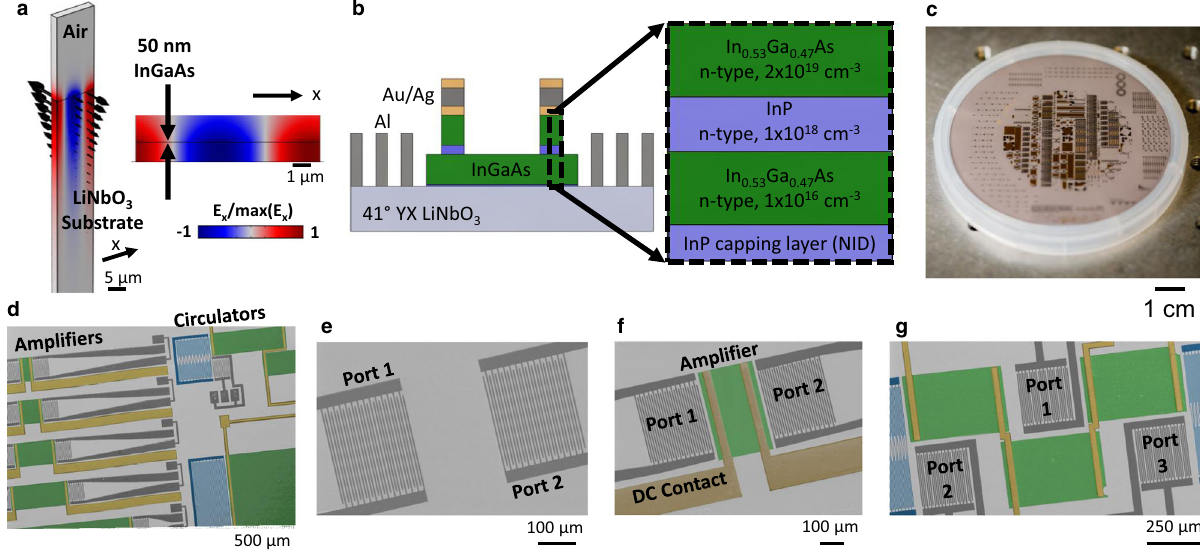
Fig. 1 Material platform overview. a Longitudinal electric fi eld ( E x ) from a fi nite element model, with displacement fi eld indicated by the black arrows, and ( b ) a schematic of our implementation of the acoustoelectric effect for an In 0.53 Ga 0.47 As thin fi lm on a LiNbO 3 substrate. c Image of the heterostructure wafer after processing. d False-colored SEM images of a wafer with passive and active acoustic wave fabricated devices including ( e ) delay lines, ( f ) ampli fi ers, and ( g ) circulators. In the false-colored images, the LiNbO 3 substrate is light gray, the In 0.53 Ga 0.47 As thin fi lm is green, the RF transducers are dark gray, the DC contacts are gold, and the RF couplers are